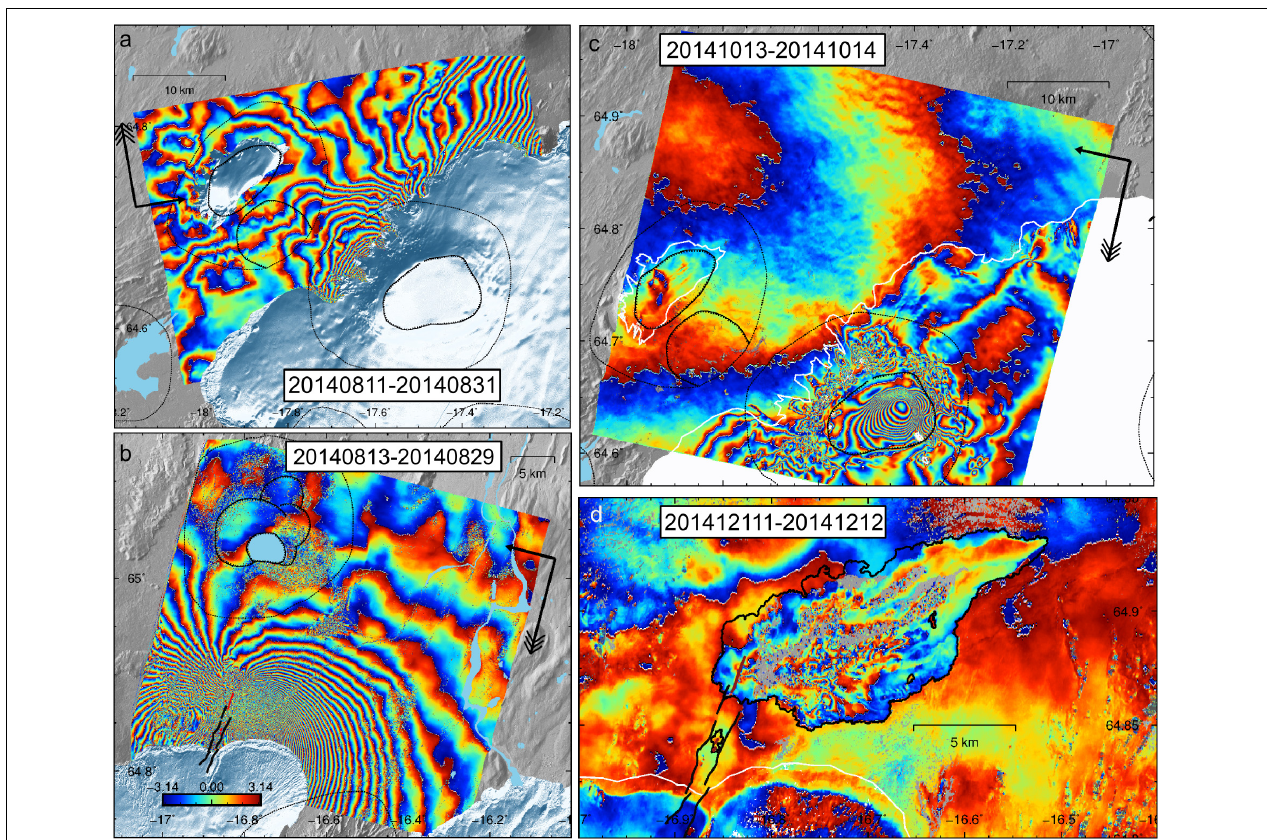
FIGURE 4 | Mapping surface deformation using SAR interferometry at Bár ð arbunga caldera and Holuhraun eruption site. Wrapped interferograms formed using CSK images illustrate different surface deformation patterns: (a) the subsidence outside the Bár ð arbunga volcano caused by the withdrawal of the magma chamber into the propagating dyke that induced a horizontal dominated surface displacement north of the scene; (b) Northern tip of the dyke propagation where the effusive eruption initiated; (c) subsidence of the ice-capped Bár ð arbunga caldera captured by 1-day interferogram and illustrating the 6-month slow caldera collapse. (d) 1-day descending interferogram over the lava field can reveal the most active lava channels (decorrelating areas) and those where lava keeps flowing or inflating at slower rate. Central volcanoes are shown using black dotted lines, calderas using dashed lines, graben borders and eruptive fissure using black and red lines respectively, and the glacier borders in white. Simple black arrow indicates the Line-of-Sight direction, the triple arrows the satellite flight direction.